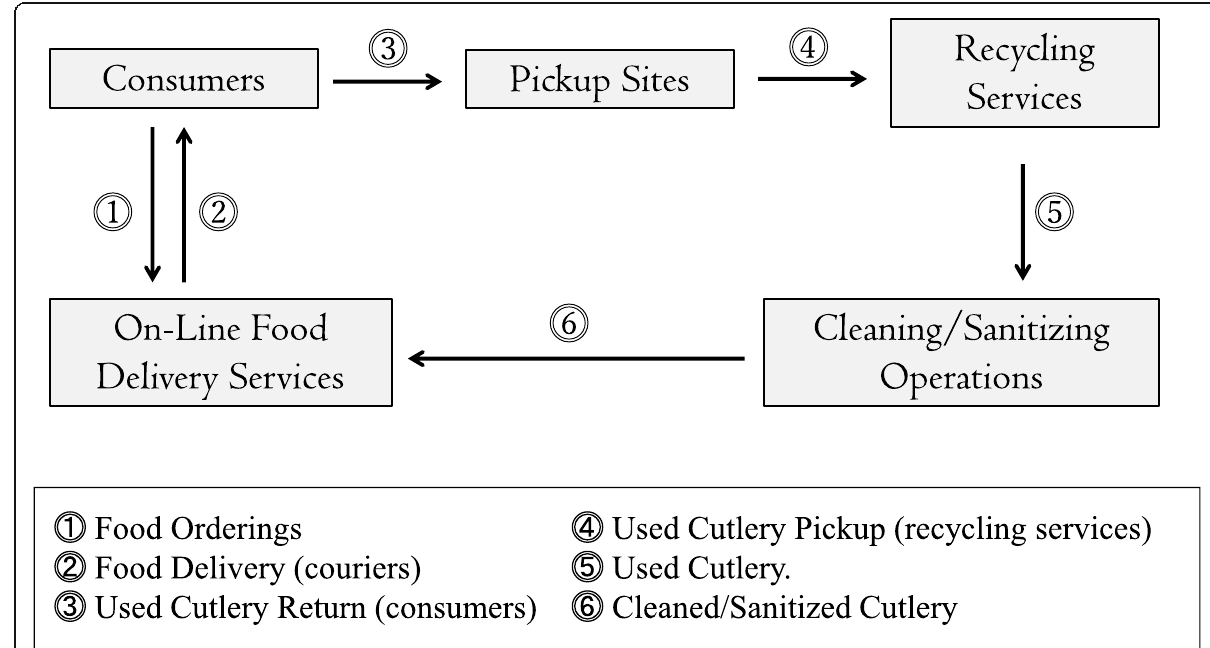
Fig. 3 Scheme that facilitates the reuses and recycling of plastics cutlery in on-line food delivery services in Taiwan